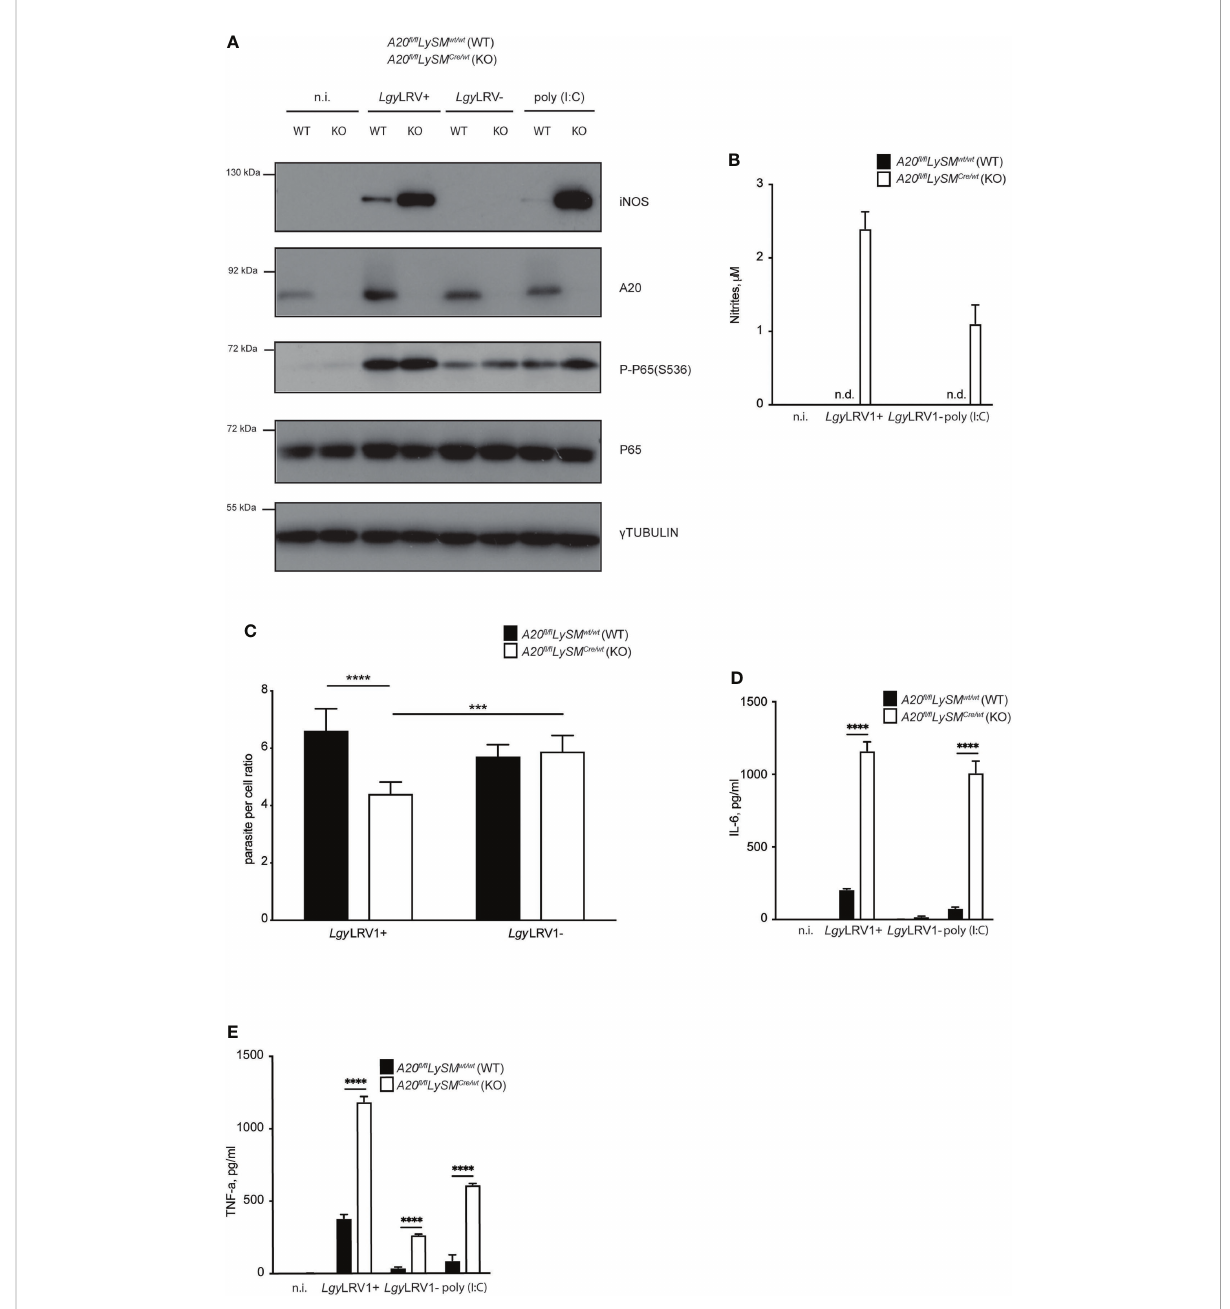
FIGURE 5 Lgy infection minimizes iNOS expression by suppressing NF- k B via A20 induction. (A) WT or A20 fl / fl LySM Cre/wt (KO) BMDMs were infected with Lgy LRV1+, or Lgy LRV1- (MOI 10), stimulated with poly (I:C) (2 m g/ml), or left untreated for 12h. Total cell lysates were analysed by western blot for iNOS, A20, P-P65(S536), P65 and g -tubulin expression. (B – E) - WT or (KO) BMDMs were treated as in (A) for 48h. Levels of parasitemia were measured by high content microscopy (C) . SNs were collected and levels of nitrites (B) , IL-6 (D) and TNF- a (E) were analyzed by Griess assay and ELISA, respectively. Data show mean ± SD from a representative of three independent experiments (B – E) . Representative blot is shown from at least three independent experiments in (A) . Statistical signi fi cance is calculated using unpaired Student ’ s t test in (C) and Tukey ’ s multiple comparison test in (D) and (E) . Not signi fi cant (NS), ***p < 0.001, ****p < 0.0001. n.i. – non-infected. n.t. – non-treated. n.d. - not